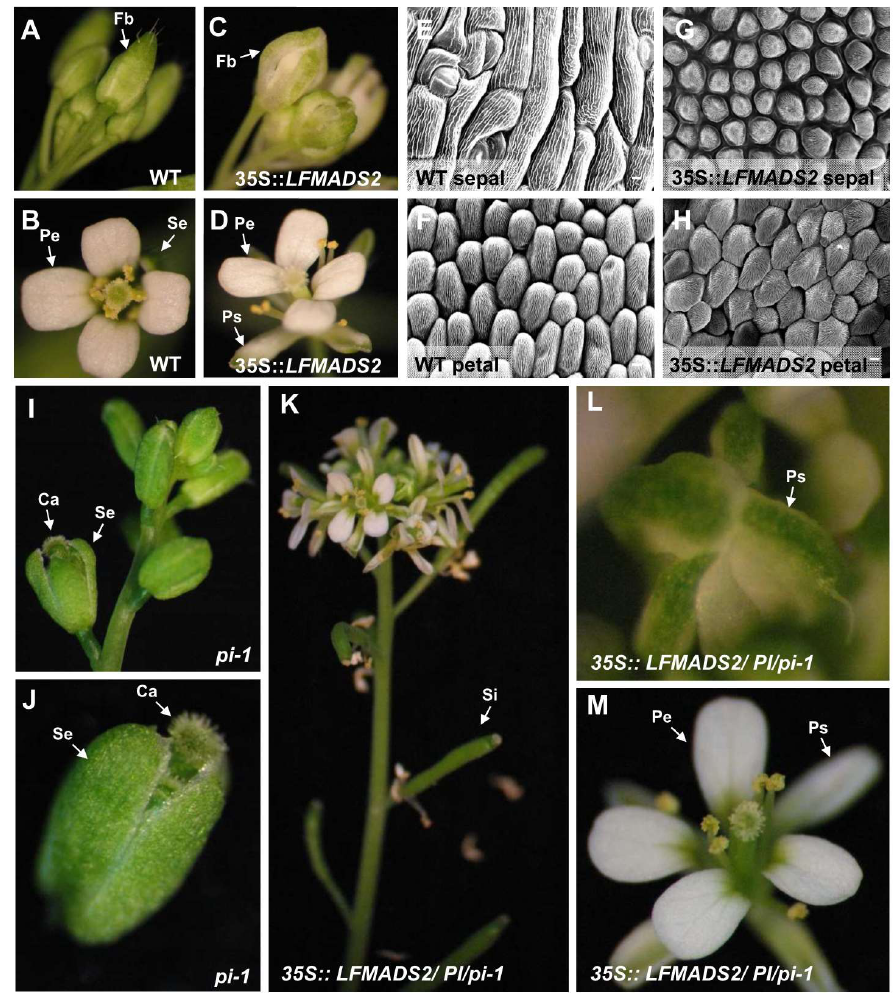
Figure 7. Phenotypic analysis of transgenic Arabidopsis overexpressing LFMADS2 in wild-type (Columbia ecotype) and pi-1 mutant (Landsberg erecta ) background, respectively. ( A , B ) Normal floral bud and open flower phenotype in wild-type. Fb: floral bud. ( C , D ) Homeotic transformation of floral bud and open flower in 35S::LFMADS2 transgenic Arabidopsis . Of note, the flower showed the complete conversion of the sepal into white-like petaloid sepal (Ps) in the first whorl. ( E , F ) Scanning electron micrographs of surface cells of second whorl (petal) ( E ) and first whorl (sepal) cells ( F ) observed in the wild-type. ( G , H ) Scanning electron micrographs of surface cells of first whorl (petaloid sepal) ( G ) and second whorl (petal) cells ( H ) observed in the 35S::LFMADS2 transgenic Arabidopsis . The shape of cell and cell arrangement in the first whorl and second whorl showed phenotypically similar to the mature wild-type petal in ( E ). ( I , J ) The apical inflorescence structure ( I ) and flower phenotype ( J ) in homozygous pi-1 mutant. The floral organ in pi-1 lacks petal and stamen structures. ( K , M ) The phenotype of the apical inflorescence structure ( K ), floral bud ( L ), and open flower ( M ) in 35S::LFMADS2/PI/ pi-1 transgenic line C1 ( PI/pi background). The flower in this transgenic line recovered four normal petals completely and sepals also showed a white margin similar to the petaloid sepal of ( D ). Bar = 20 µ m. Se: sepal, Pe: petal; Ps: petaloid sepal; Si: siliques. Next, we performed the phenotypic analysis for 35S::LFMADS4 transgenic Arabidopsis and discovered that floral transition plants showed extreme early flowering and produced fewer, smaller, and curly rosette leaves (Table 2, Figure 8A,B). In contrast to the inflorescence development in wild-type, fewer lateral inflorescence and 2,3 flowers were produced at the apical of the main inflorescence in 35S::LFMADS4 transgenic plants (Figure 8A,B). The normal floral organs in WT composed of